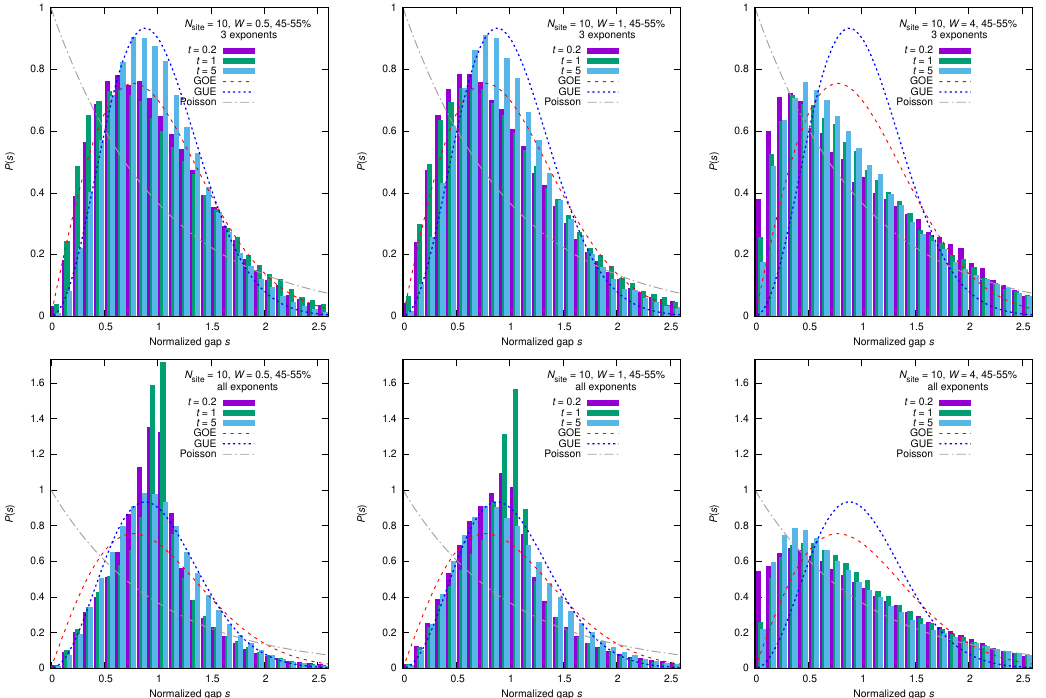
Figure 19 . XXZ model, distribution of the normalized gap P ( s ). N site = 10 and 900 samples have been used for each case. The (cid:12)xed- i unfolding [upper] for the two gaps between the three largest exponents and [lower] for all gaps have been used for the Lyapunov exponents obtained using 45%{55% of the spectrum for each sample, in which 0% corresponds to the ground state. Left: W = 0 : 5. Middle: W = 1. Right: W =